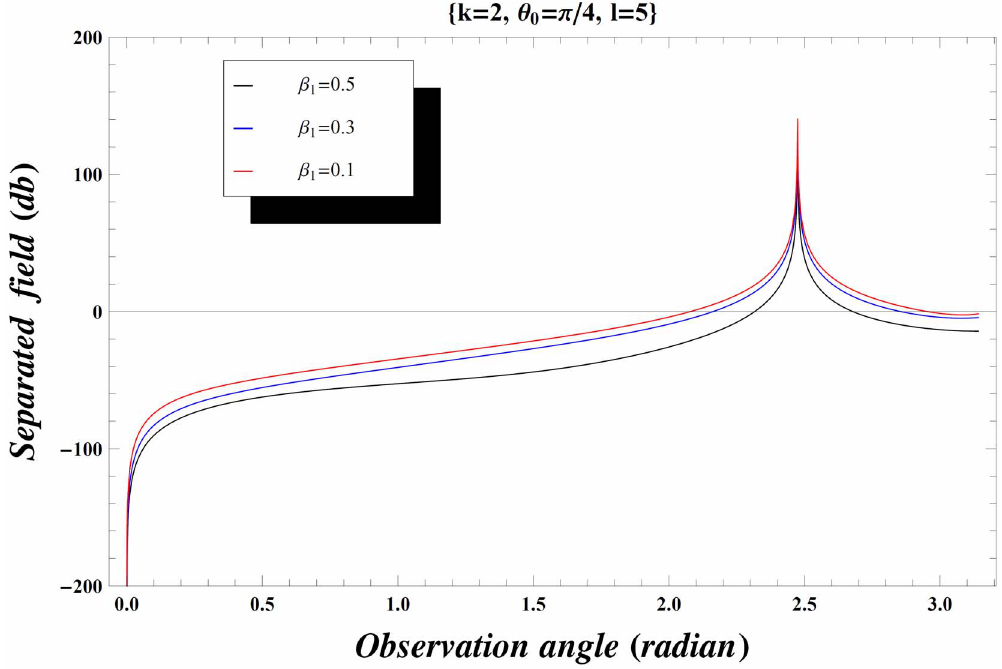
Figure 6. Separated field versus observation angle for different values of admittance parameter b 1 when k ~ 2 .